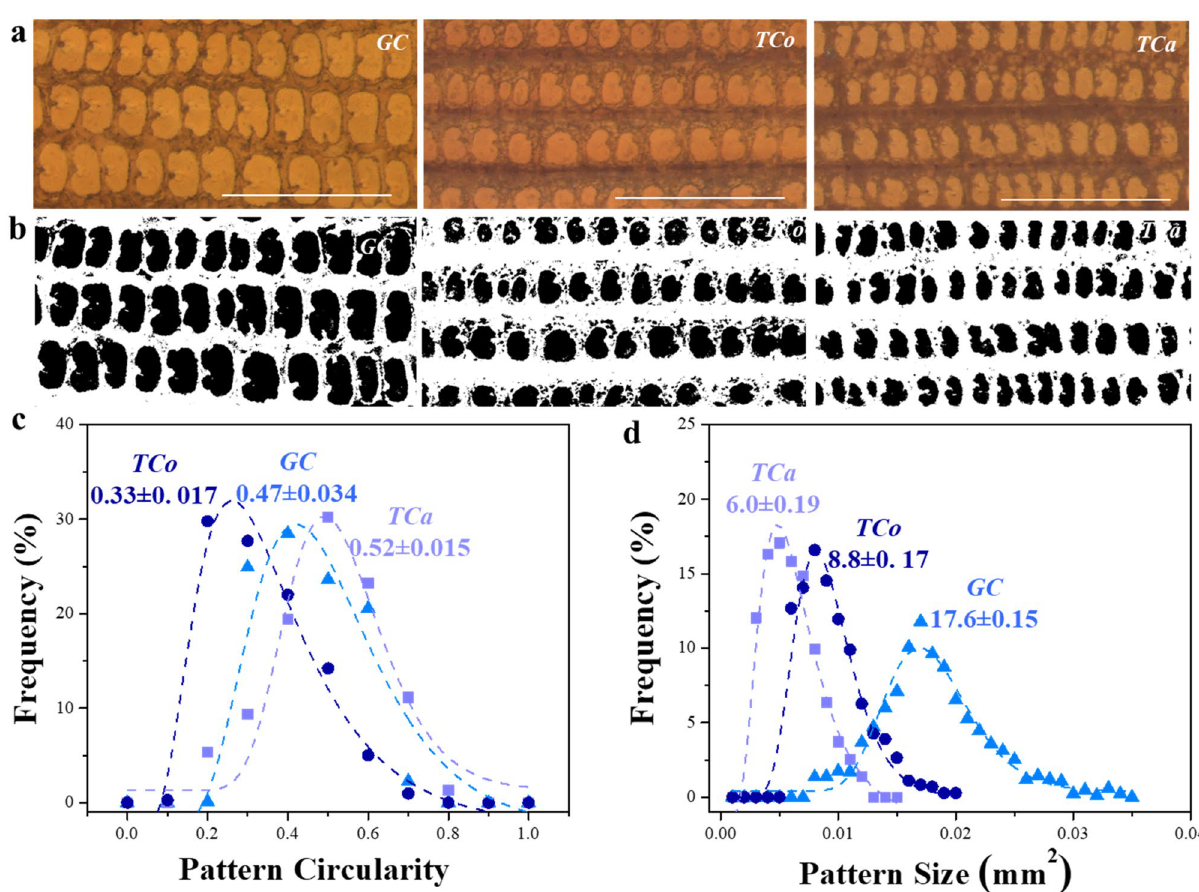
Figure 6. Analysis of elytra patterns for 3 different species, namely G. cornutus (GC), T. confusum (TCo), & T. castaneum ( TCa ) belonging to the same family Tenebrionidae. (a) optical images captured in Trans illumination at 100x magnification showing elytra patterns, with the scale bars being 250 µm; (b) the corresponding binary image, that shows only the dominant patterns. The log-normal distribution of (c) ‘circularity’ (shape) and (d) ‘size’ of the patterns for the three different species. It can be noted that the shape of the patterns are similar (close ‘circularity’ distribution) for the species belonging to the same family . But the ‘size’ distribution varied for three species with TCo & TCa belonging to the same genus Tribolium , much closer compared to the other family member GC. The indexed numbers show the mean and SD of the distribution, with the size values bearing units of 10 –3 mm 2